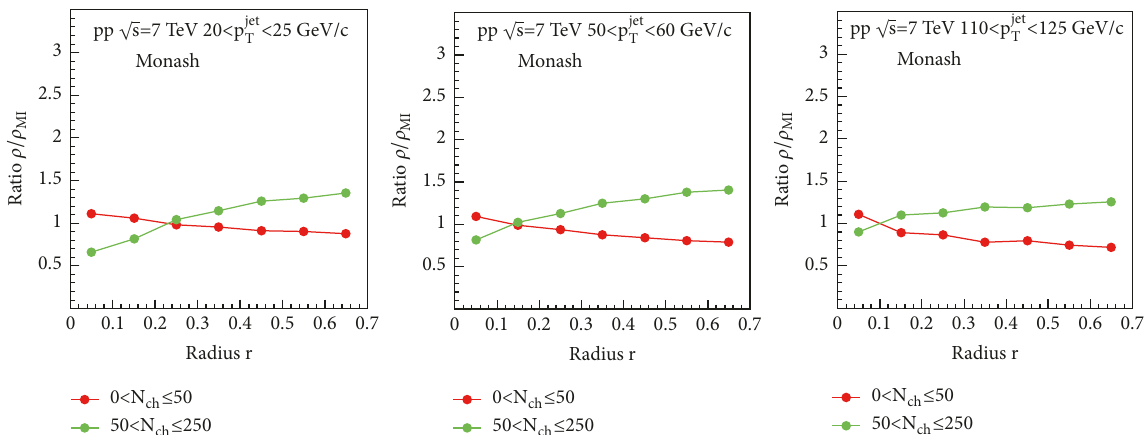
≤ 50 , red ) and high-multiplicity events ( 𝑁 ch < 60 GeV /𝑐 (center), and 110 GeV /𝑐 < 𝑝 jet T